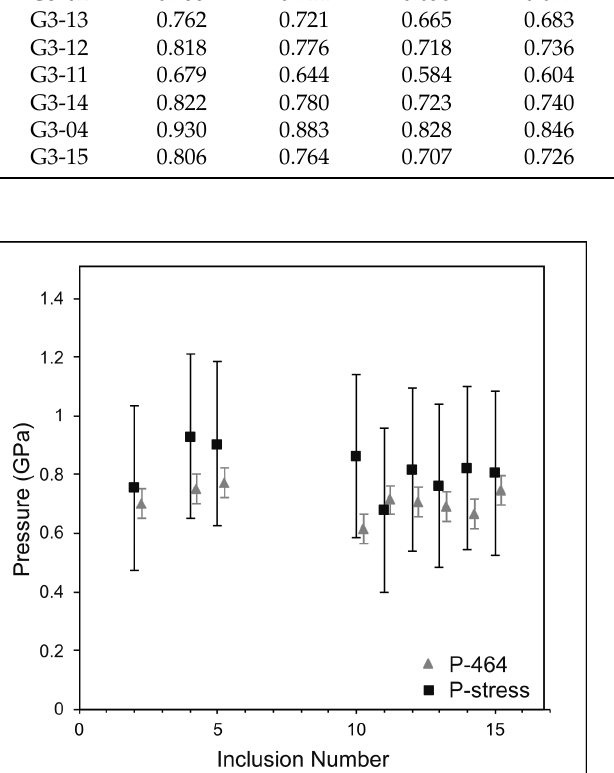
Figure 2. Comparison of P-stress calculated using Strainman [24] with EntraPT [44] and P-464 calculated using the hydrostatic mode shift calibration of [30]. Each pair of points represents a single inclusion with numbers corresponding to the Inlc. names above (Tables 3 and 4). The x-axis has been expanded for ease of